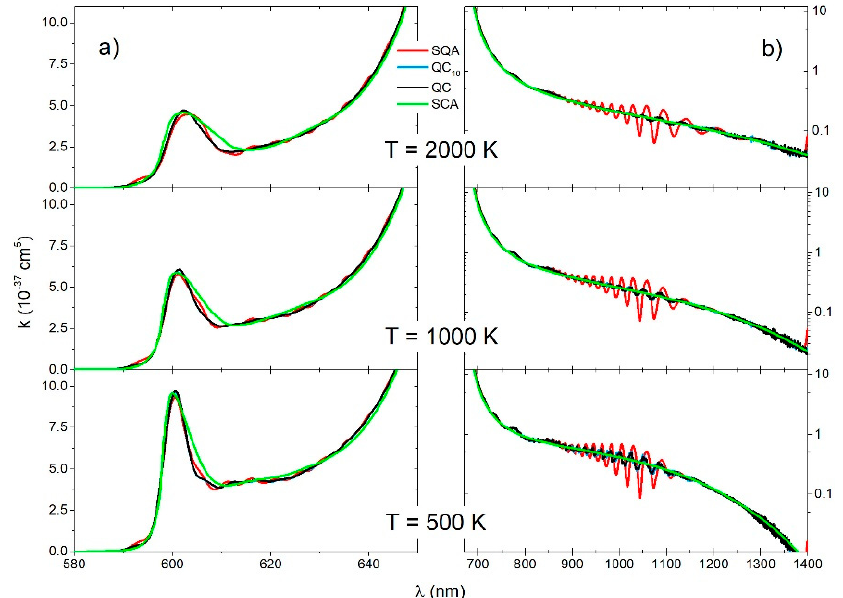
Figure 4. Li 2 molecule, reduced absorption coefficient for the ( a ) c 3 Π g → a 3 Σ + u and ( b ) b 3 Σ + g → a 3 Σ + u transitions for three different temperatures (2000 K, 1000 K, 500 K), obtained with four theoretical approaches (SQA, QC 6 , QC, SCA).